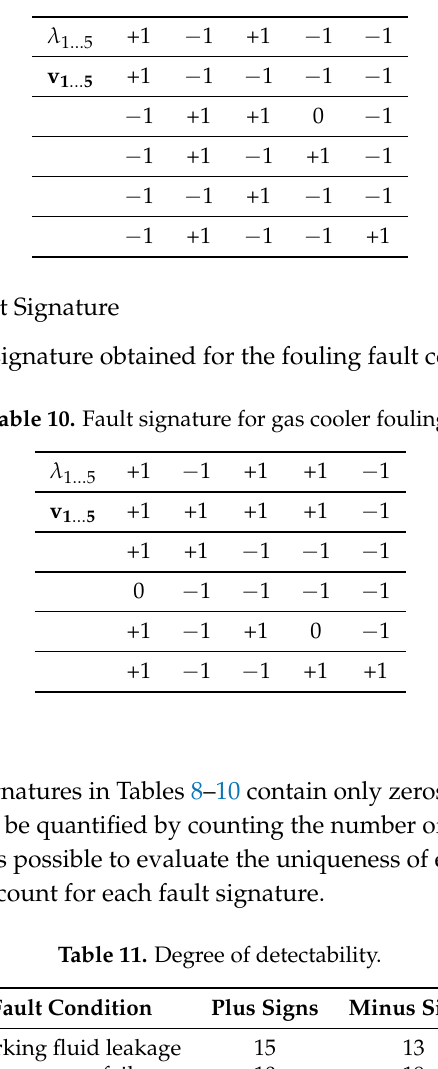
Table 9. Fault signature for compressor failure.